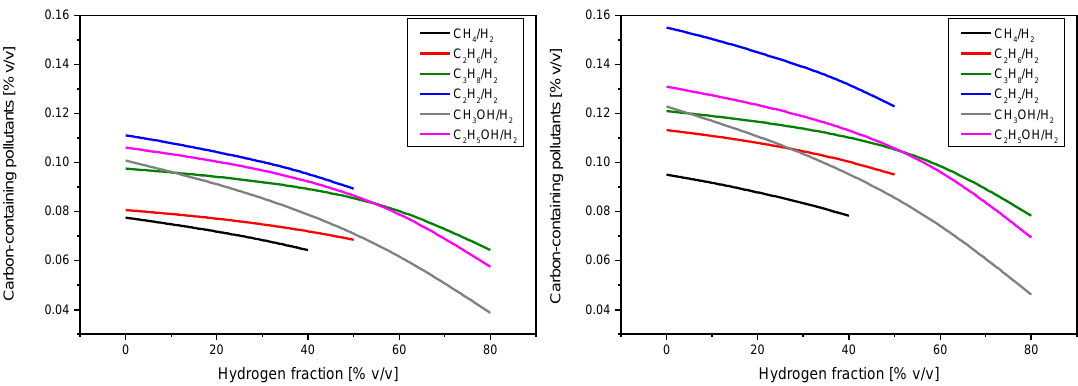
Figure 7. The impact of hydrogen fraction on carbon-containing pollutants at lean ( left ) and stoichiometry ( right ) compositions.